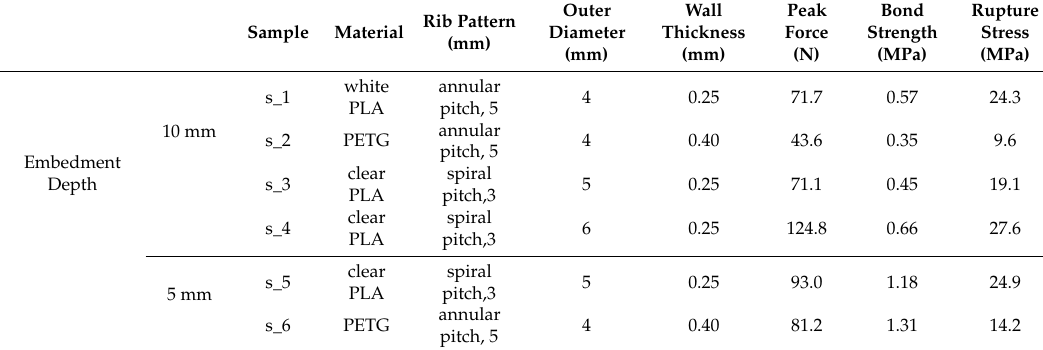
Table A2. Pull-out test results.